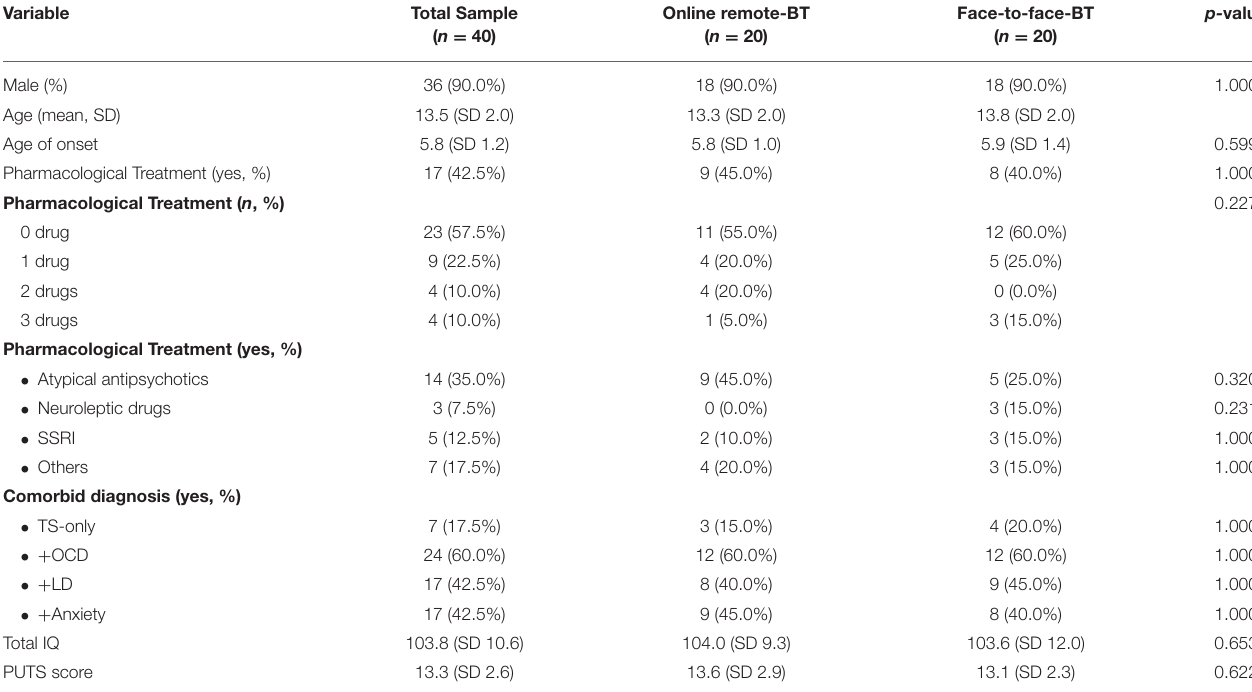
TABLE 1 | Participant